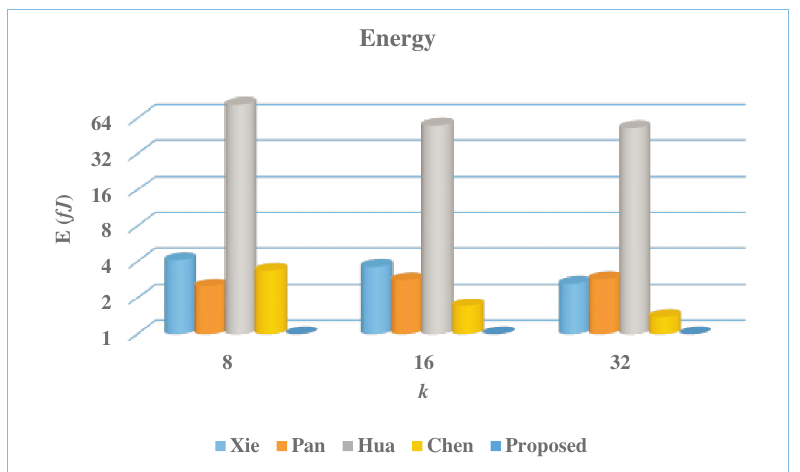
Figure 14. Consumed energy